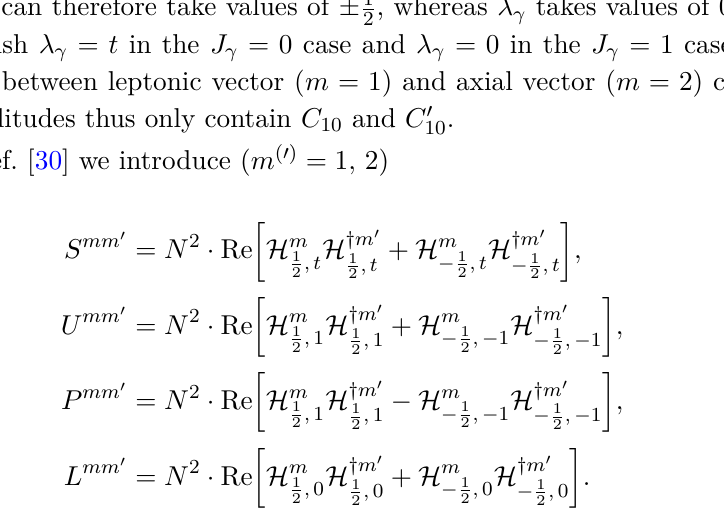
can therefore take values of ± 1 p = t in the J γ